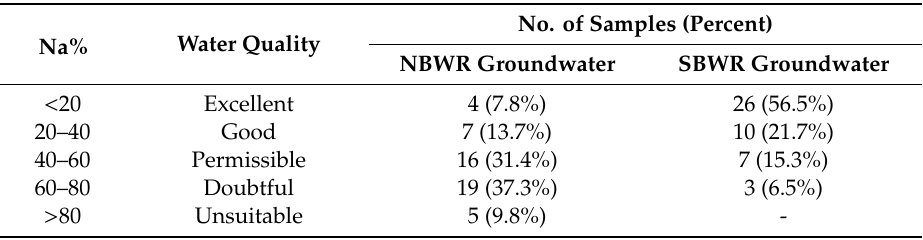
Table 4. The classifications of groundwater quality for irrigation based on the Na%